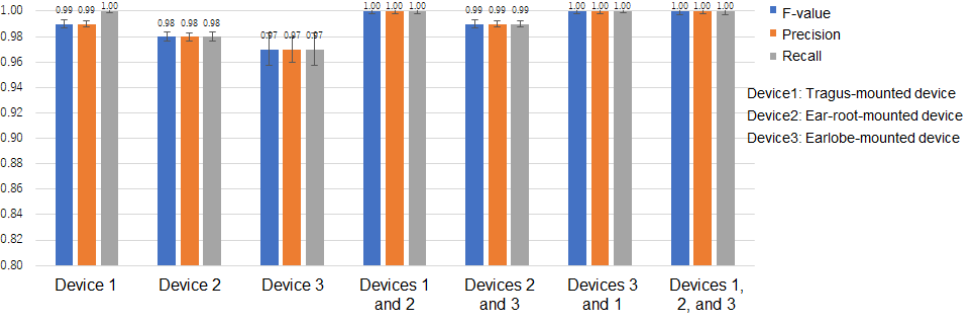
Figure 11. The results of Evaluation 2 using six gestures. The average value for each device